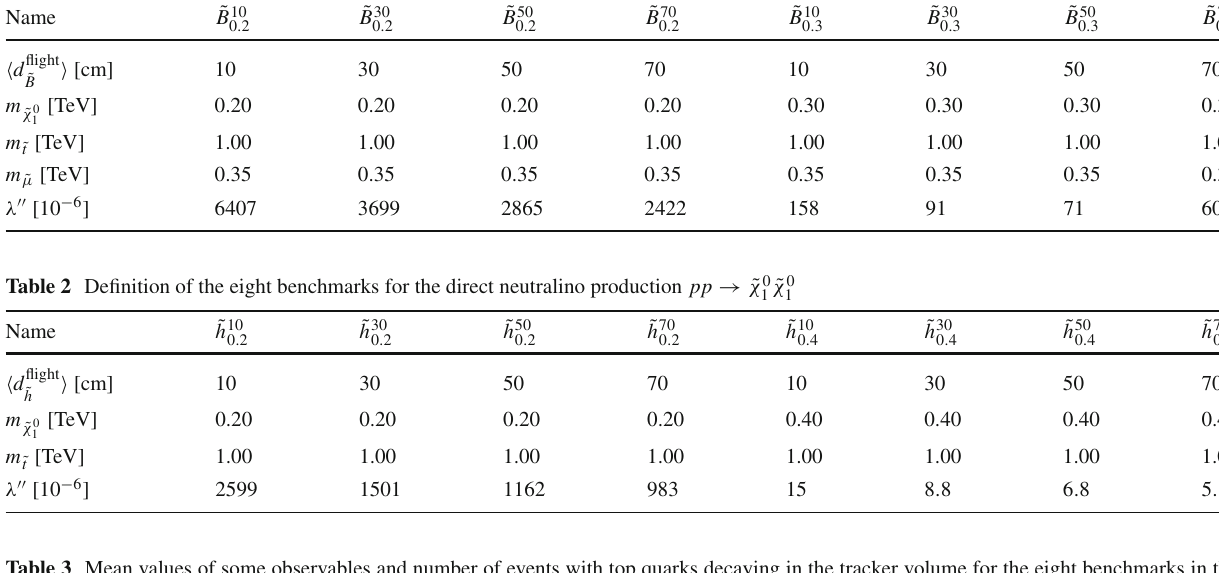
Table 1 Definition of the eight benchmarks for the smuon production case pp → ˜ μ ¯˜ μ